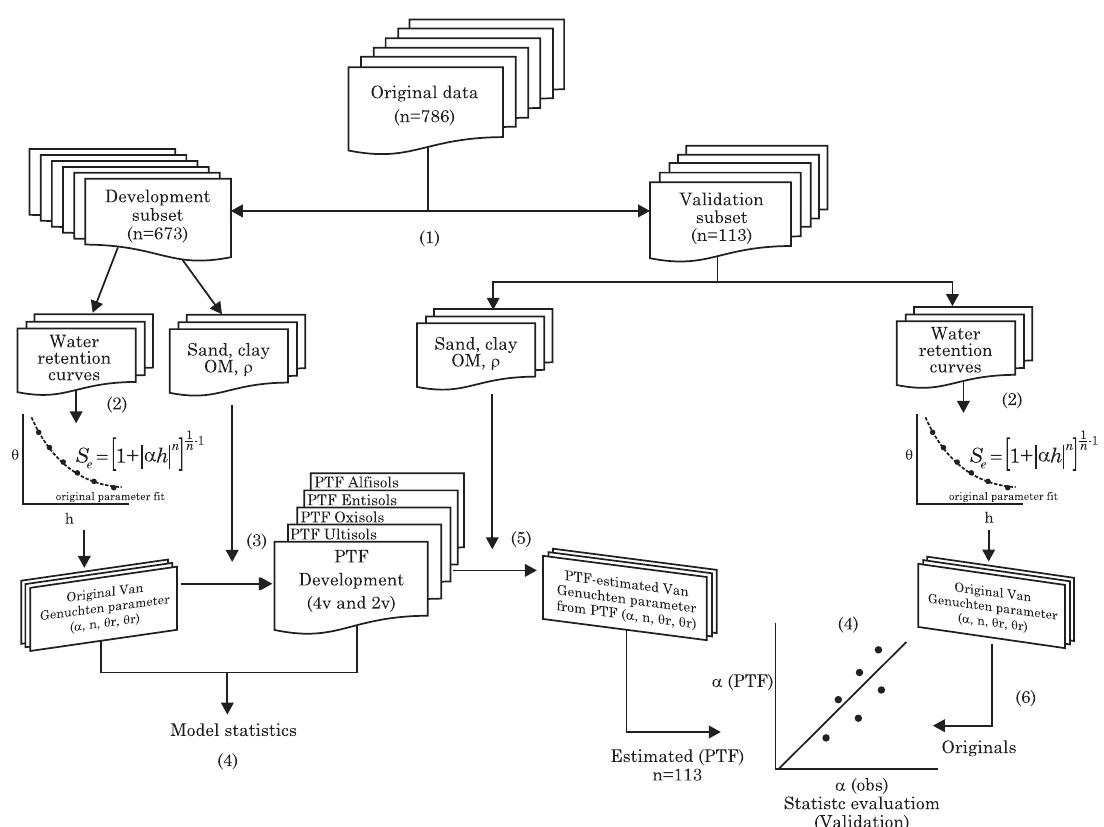
Figure 2. Schematic representation of the methods used to perform external validation of pedotransfer functions.